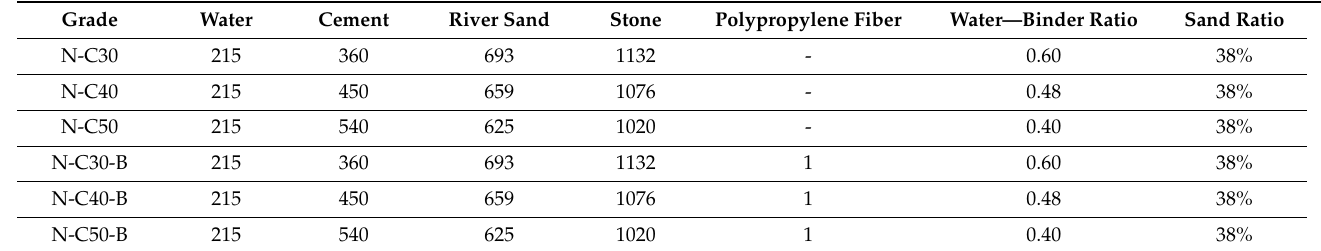
Table 5. Ordinary concrete mix ratio (kg/m 3 ).